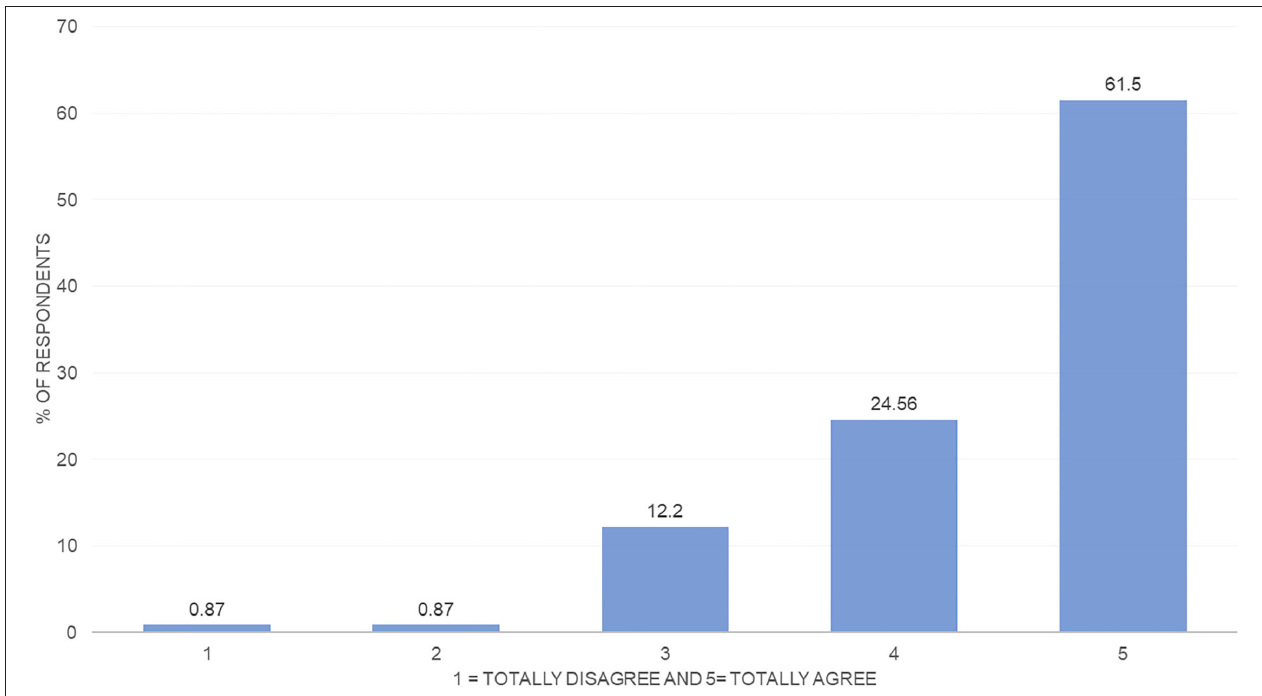
FIGURE 2 | Intention to not waste food —distribution. Source: Own elaboration.